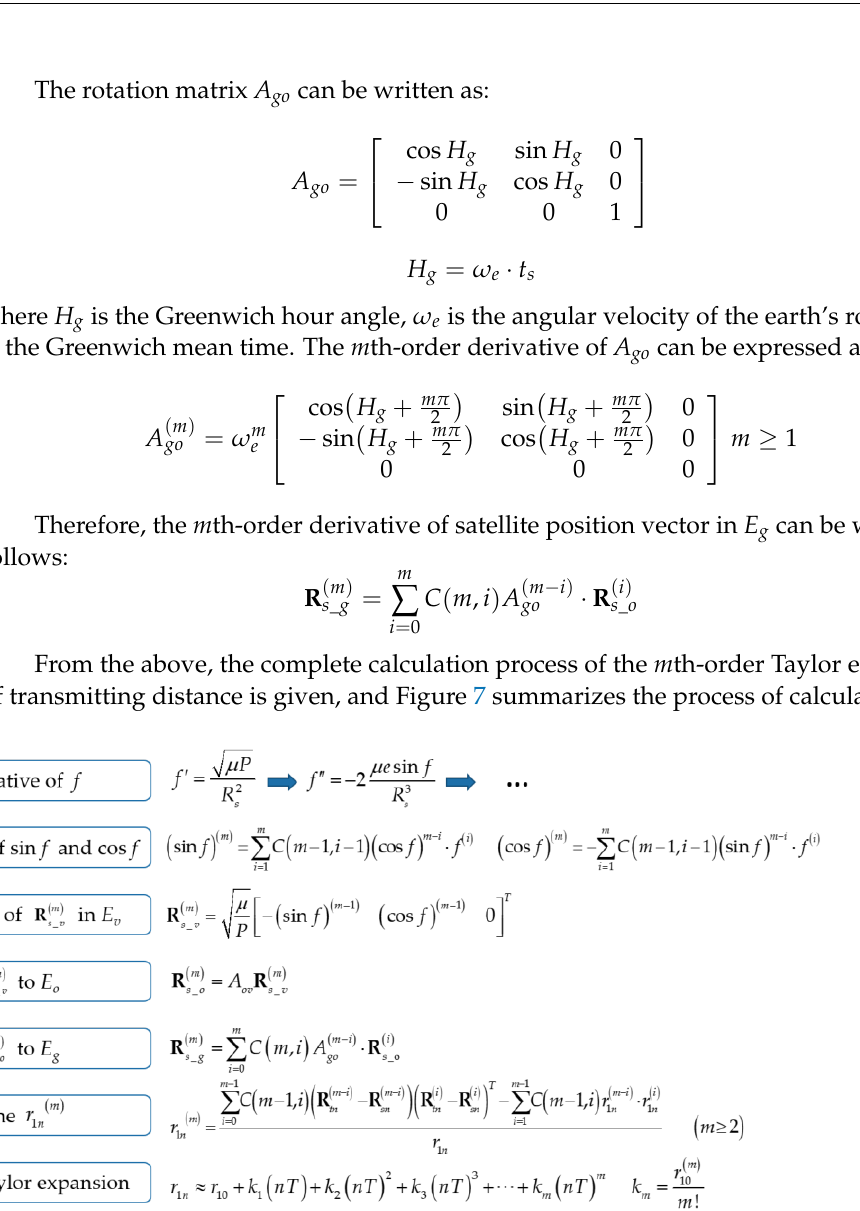
Figure 7. The Flowchart of the m th-order Taylor expansion process of the pulse transmitting distance in GEO SAR.